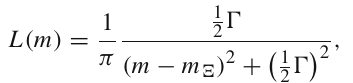
Table 1 (cid:2) distance cut between primary and secondary vertex in the z (beam) direction for different rapidities